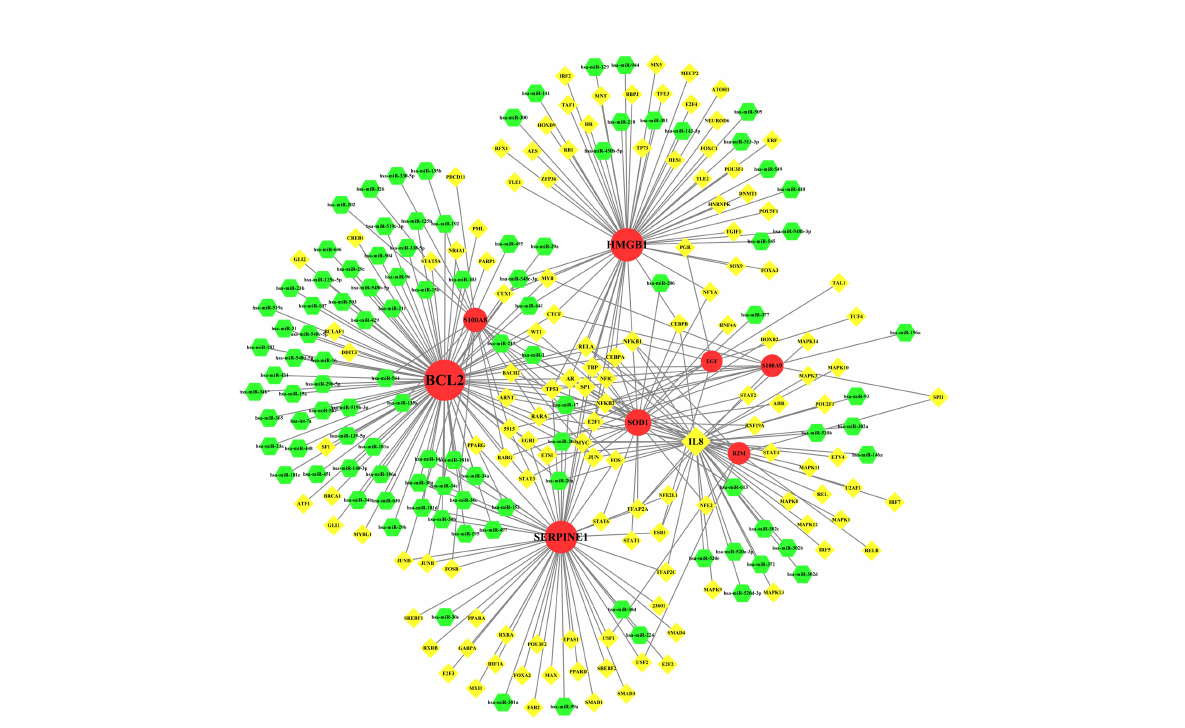
FIGURE 8 The network presents the TF-miRNA coregulatory network. The network consists of 240 nodes and 327 edges including 130 TF-genes, 102 miRNA and 9 common genes. The nodes in red color are the common genes, yellow nodes represent miRNA and green nodes indicate TF-genes.